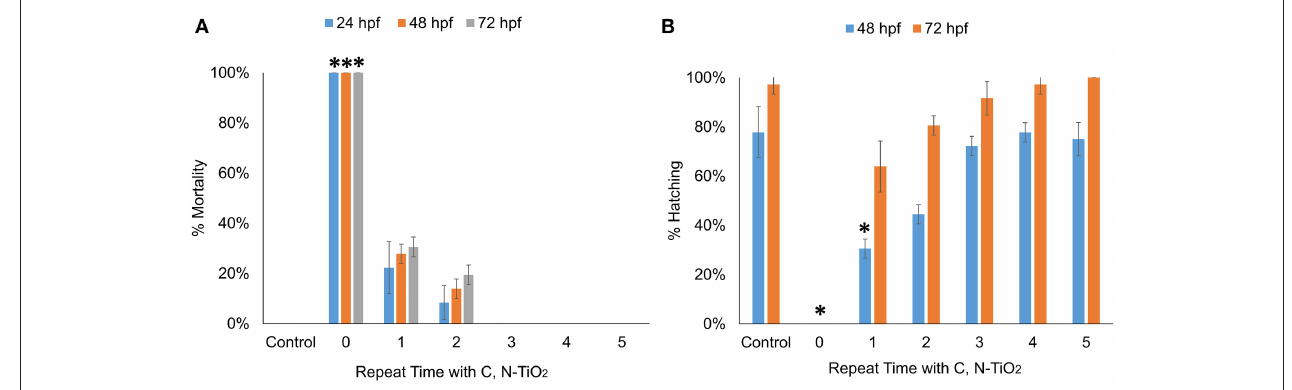
FIGURE 8 | Multiple degradation time-dependent toxicity of zebrafish embryos after 24, 48, and 72 hpf. (A) Mortality rate (B) Hatching rate. (Values are expressed as means ± S.D, * P < 0.01).